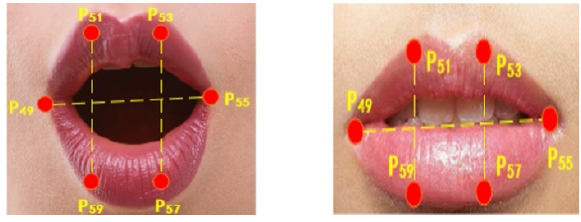
Figure 5. Mouth feature points.